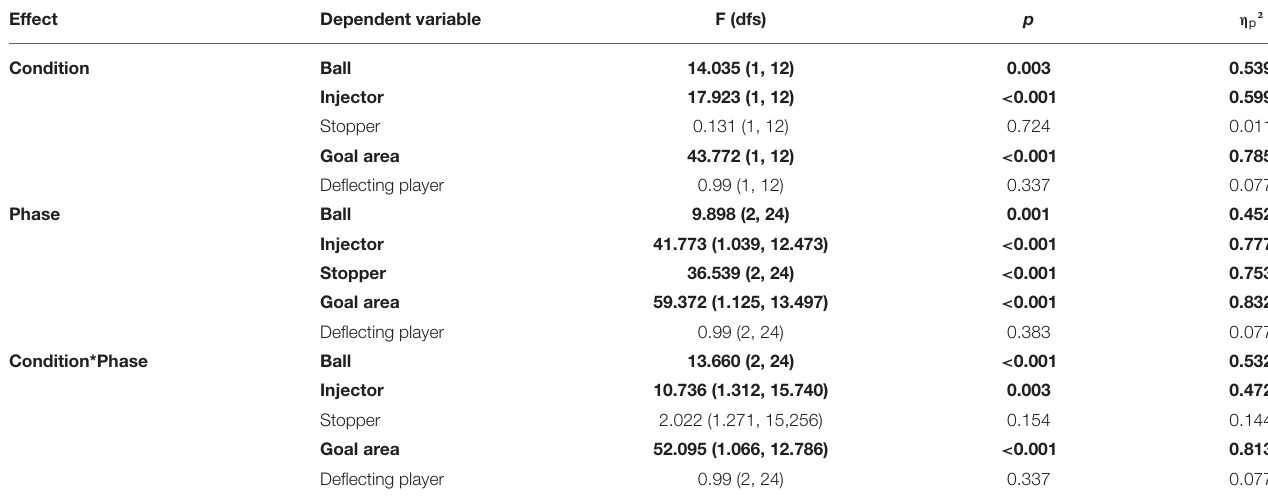
TABLE 1 | Summary of univariate analyses of gaze durations in defense-dependent and independent strategy for the three phases of the penalty corner process.